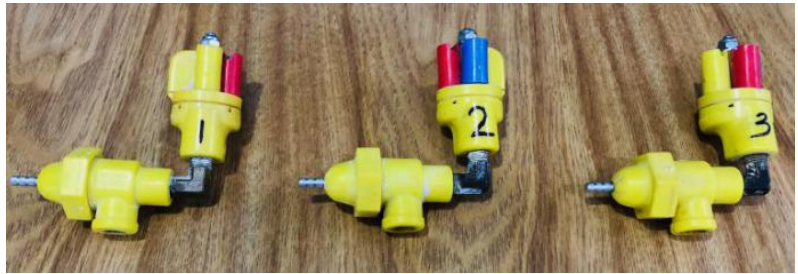
Figure 2. Nozzles tested.